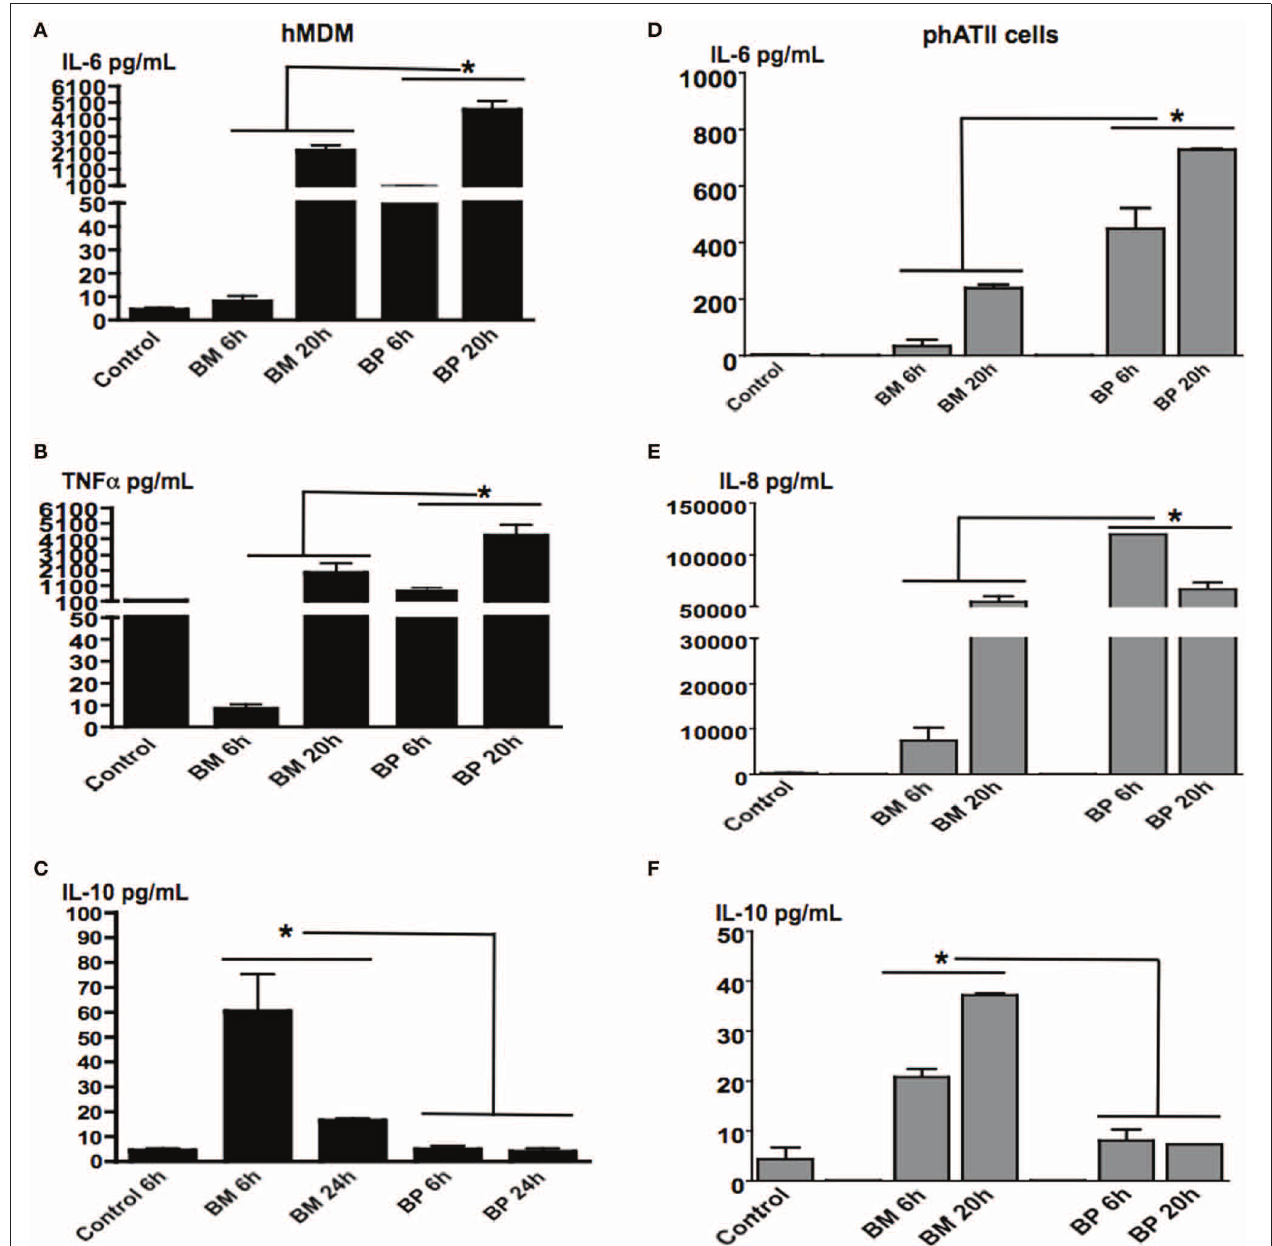
FIGURE 2 | BM and BP -induced time-dependent secretion of cytokines from ATII cells and MDM. ATII cells and MDM were infected with BM or BP (MOI 100:1) for 6 or 20h. Supernatant was collected and analyzed for cytokine secretion. Un-stimulated cells served as baseline controls. BP stimulated higher levels of IL-6 (A) and TNF- α (B) from MDM as well as IL-6 (D) and IL-8 (E) from ATII cells at 6 and 20h post-infection compared to BM .